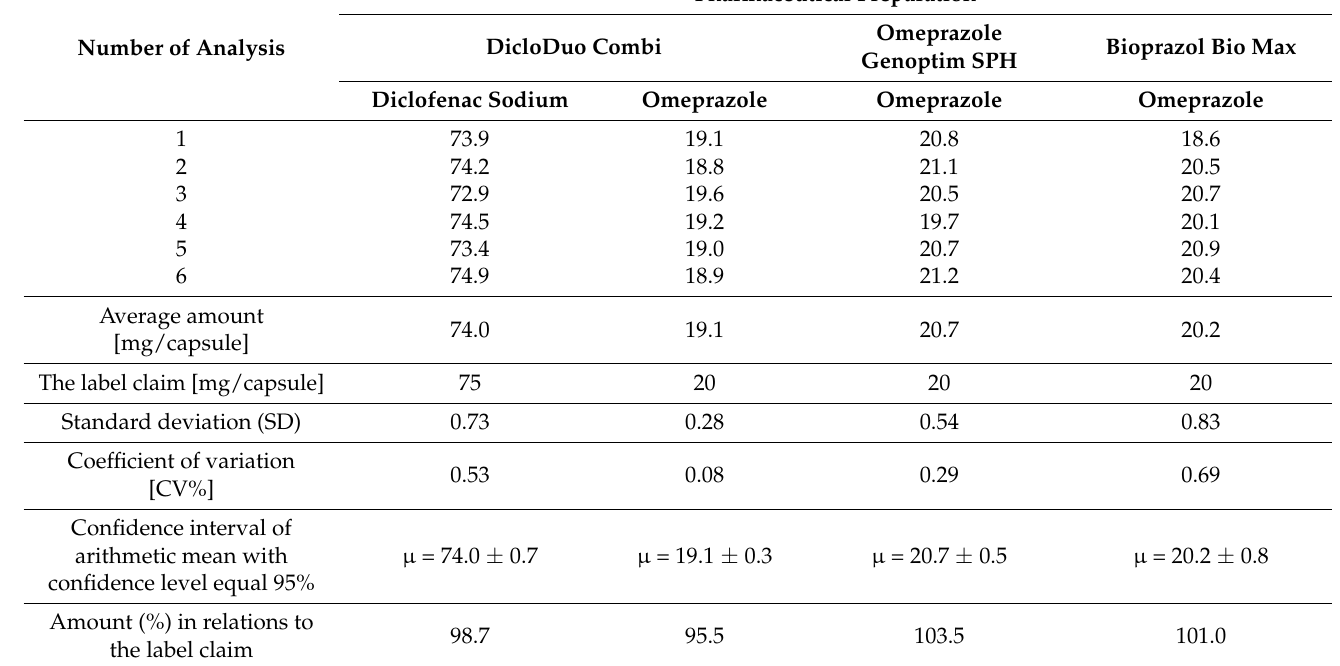
Table 7. The statistical data concerning the results of the quantitative determination of omeprazole and diclofenac sodium in commercial simple and combined pharmaceutical capsules examined by elaborated NP-TLC with densitometry